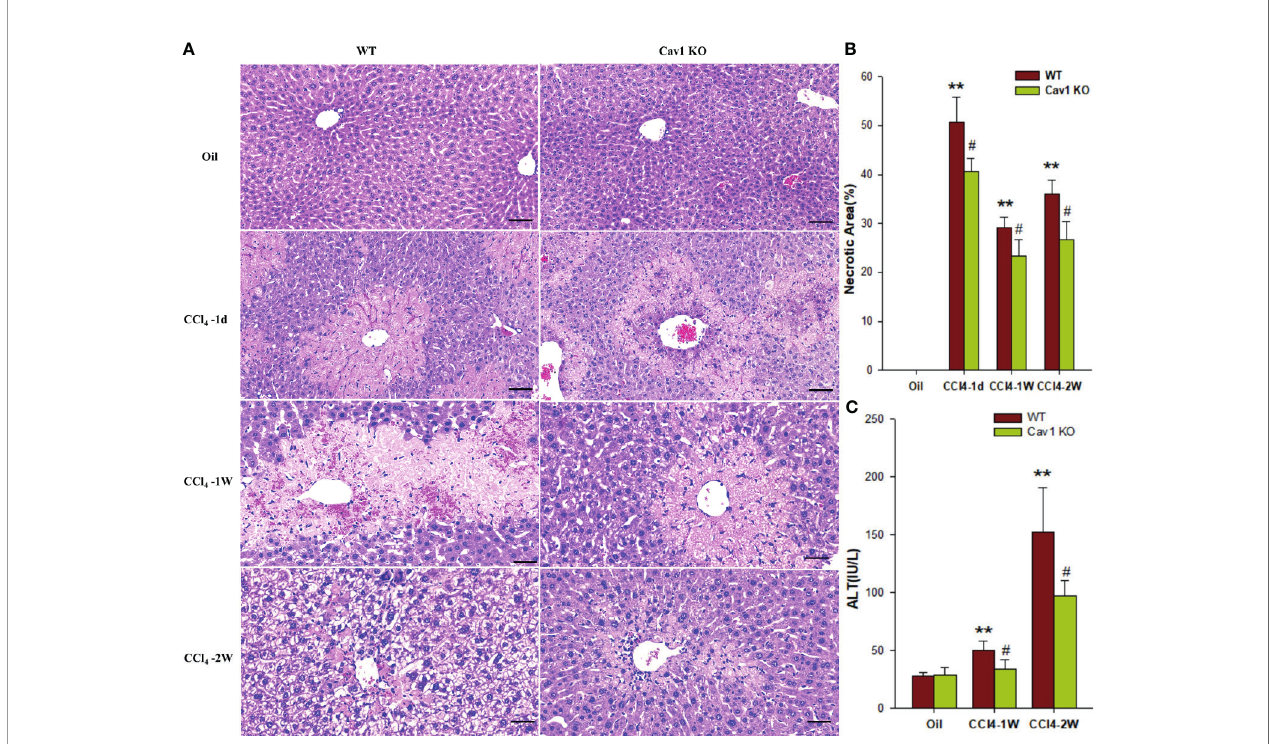
FIGURE 1 | Cav1 de fi ciency attenuated degeneration and necrosis of hepatocytes in CCl 4 -induced liver damage. Cav1 KO and WT mice were intraperitoneally injected with CCl 4 (10 m L/g of body weight) or olive oil. Liver tissues and serum samples were collected at 1 day, 3 days, 1week, and 2 weeks after injection. (A) Representative images of H&E-stained liver sections. Degeneration and necrosis of hepatocytes were observed around the central vein. (B) Quantitative analysis of hepatocytes necrosis. Cav1 KO mice showed signi fi cantly reduced necrotic area in the liver from 1-day to 2-week post-injection compared to the WT group. (C) The serum concentration of ALT was also signi fi cantly decreased in Cav1 KO mice. Data are shown as mean ± SD, ** p < 0.01 compared with the WT+oil group, # p < 0.05, compared with the WT+CCl 4 group at the same time point. Scale bar = 50 µm. n=6 per